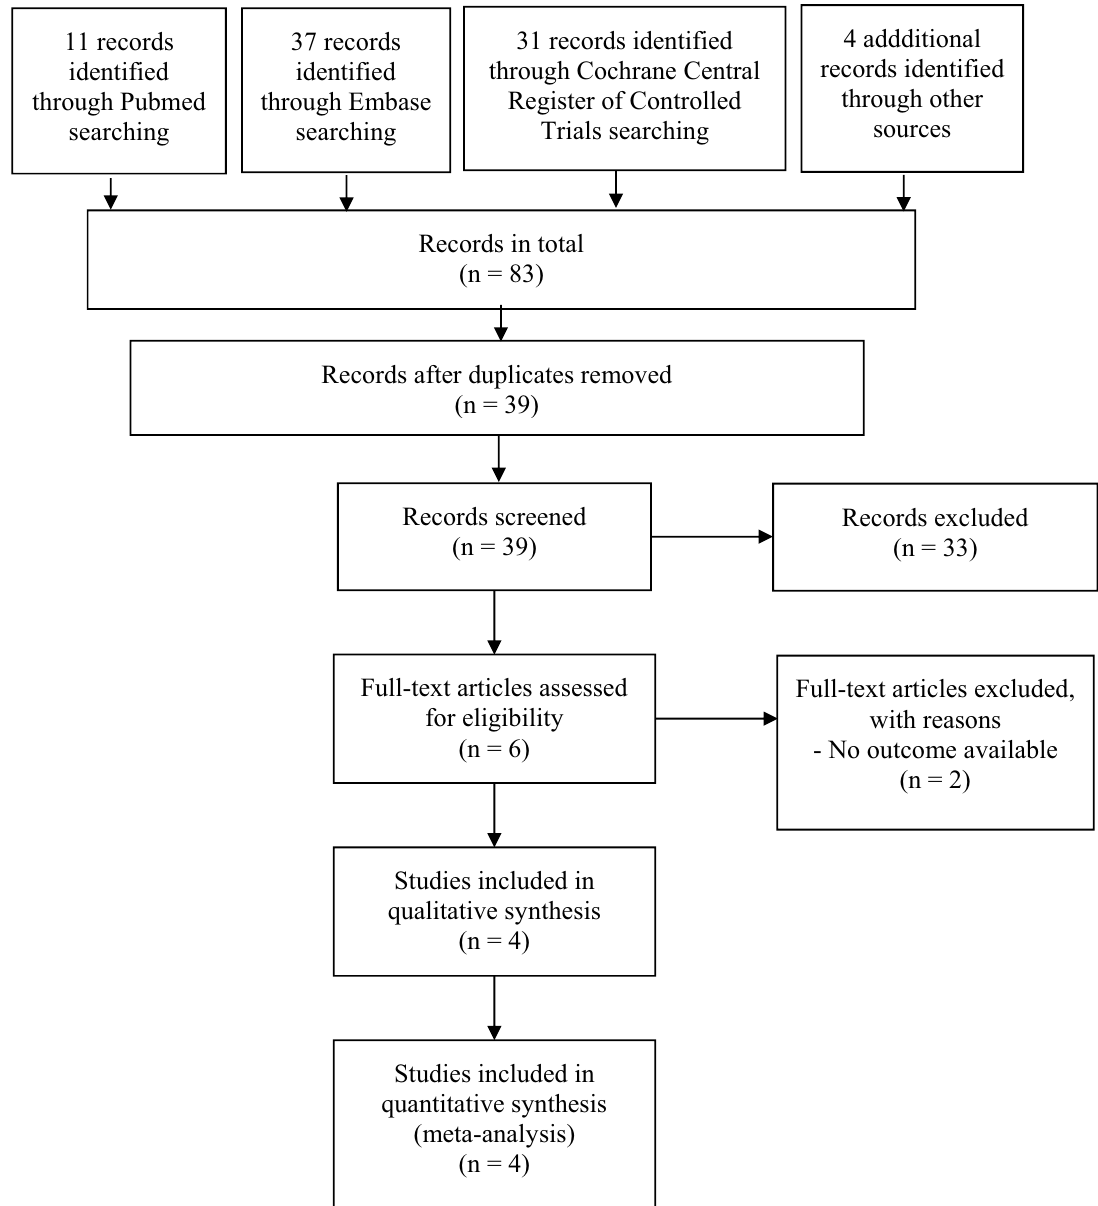
Figure 1. PRISMA flow diagram: records retrieved from database searches and trial inclusion in the systematic review of randomized controlled trials comparing olanzapine/samidorphan and olanzapine for mitigating olanzapine-induced weight gain and cardiometabolic